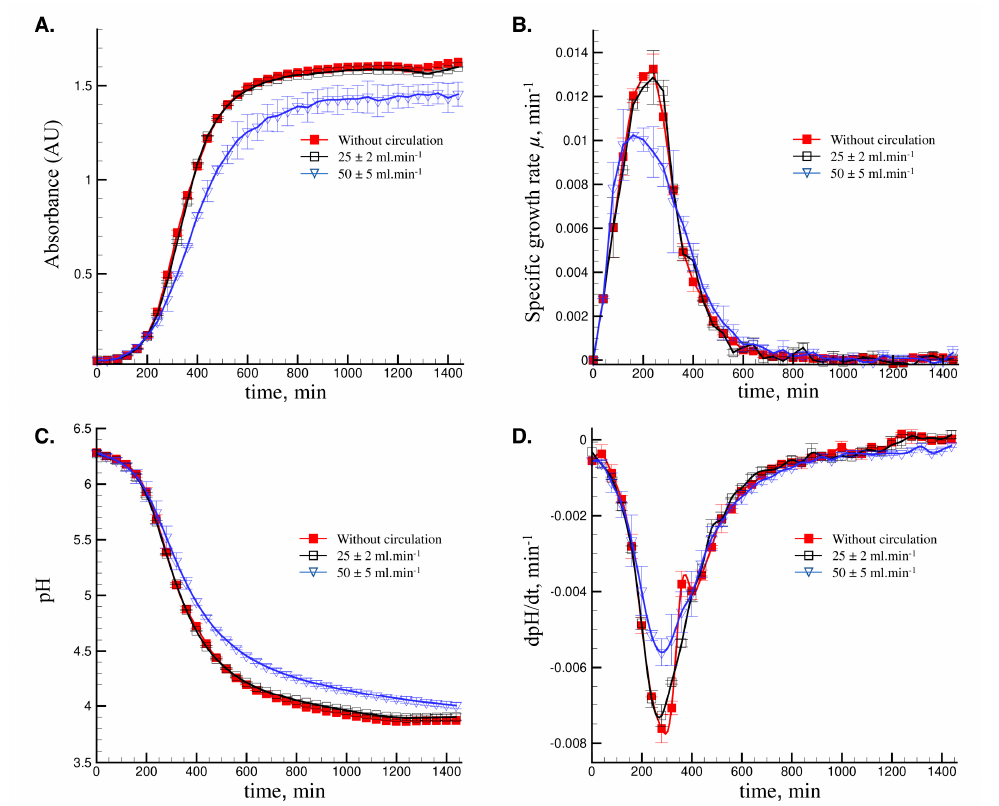
Figure 2. Growth and acidification characteristics of L. delbrueckii subsp. bulgaricus CFL1 in de Man, Rogosa and Sharpe (MRS) broth with different circulation flow rates. The fermentations were carried out with the initial OD 600nm of 0.03. ( A ) The absorbance (AU) of the media, ( B ) the specific growth rates µ of the media, ( C ) the pH values of the media, ( D ) the acidification rates (dpH/dt) of the media. The error bars represent the standard deviations of the three biological replicates.